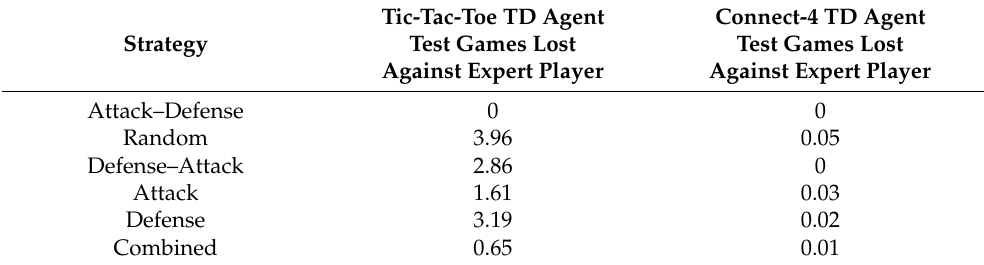
Table 4 indicates the number of test games lost by the TD agent against an expert player, out of nine test games for tic-tac-toe and four games for Connect-4. Table 4. Number of test games lost by the TD agent against an expert player.